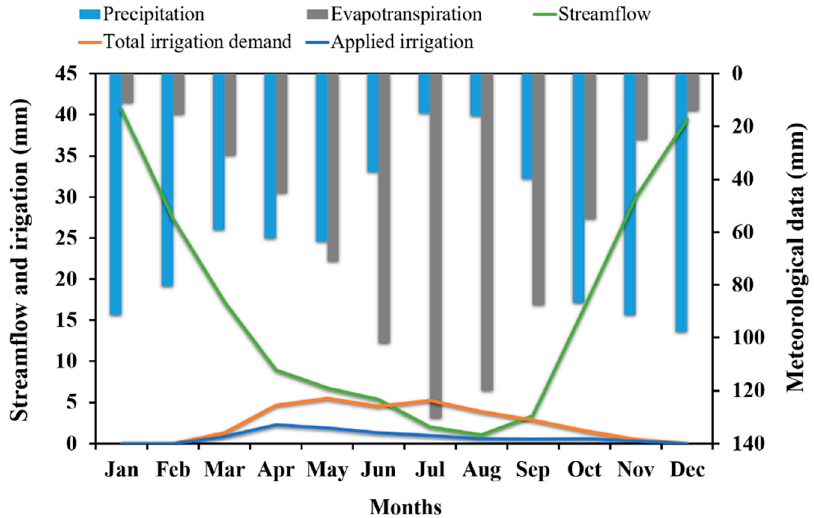
Figure 9. The streamflow, total irrigation demand, applied irrigation, precipitation, and evapotranspiration in the Sabor River basin for the period 1960–2008.